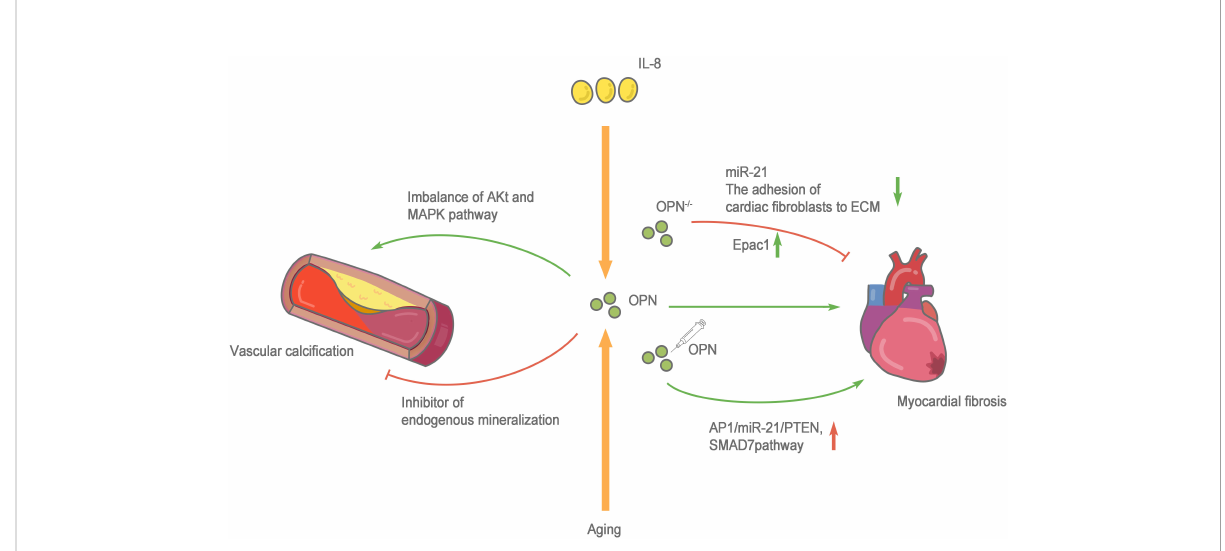
FIGURE 3 Role of OPN in cardiovascular system aging. The cytokine interleukin (IL)-18 and aging are involved in inducing OPN expression and promoting myocardial fi brosis and cardiac dysfunction. when OPN-/-, the adhesion of cardiac fi broblasts to extracellular matrices (ECM) is greatly reduced, the expression level of miR-21 decreases and b 1AR and b 2 AR are activated to enhance the production of cAMP, increasing the protein level of Epac1 to combat the fi brosis of cardiac fi broblasts. Whereas an injection of the recombinant OPN protein reactivates the AP1/miR-21/PTEN and SMAD7 pathways and enhances fi brosis. OPN has two sides to vascular calci fi cation, on the one hand, OPN activated the MAPK signaling pathway, and the imbalance of Akt and MAPK pathways leads to the switching of vascular smooth muscle cells (VSMCs) to pathological progression. on the other hand, OPN is an effective physiological inhibitor of endogenous mineralization, which can prevent ectopic calcium deposition, and is an effective inhibitor of vascular calci fi